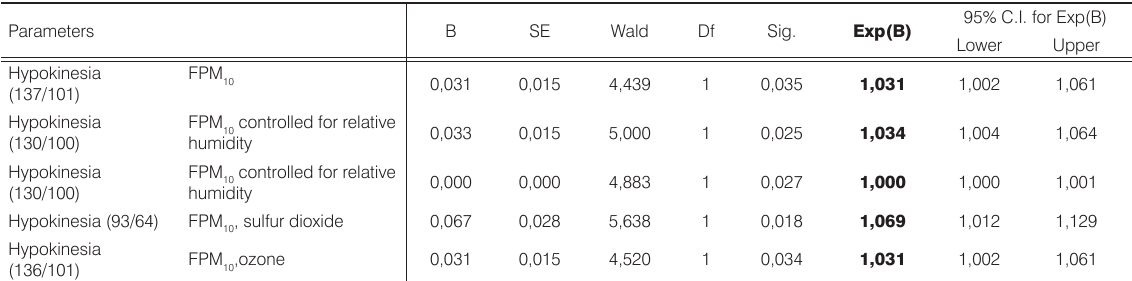
at the point of “Ian Palach St.” 10